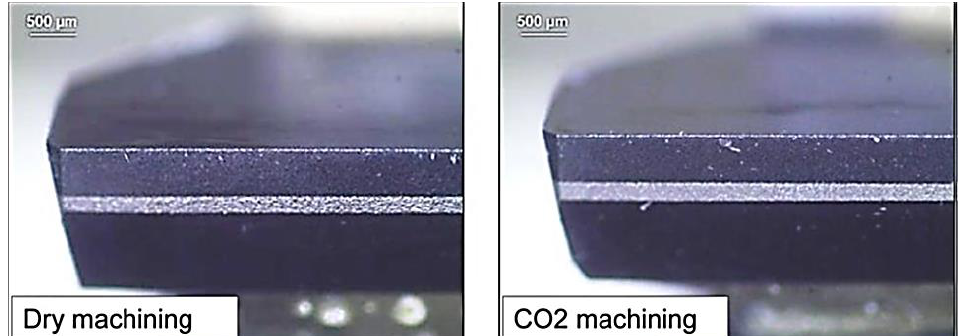
Figure 14. Comparison of dry and liquid CO 2 machining based on tool wear generated [131]. Reproduced with permission from Springer.